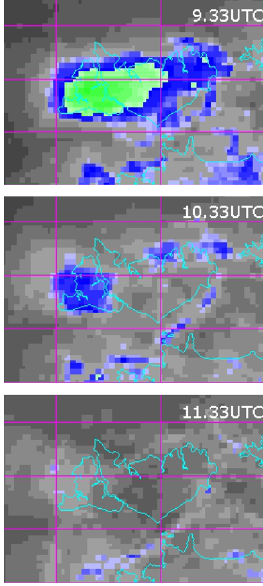
Figure 3. Close-up of GMS IR satellite images of the Tiwi Island region with the dissipating Hector clouds. The colour scale is as in Fig. 2.